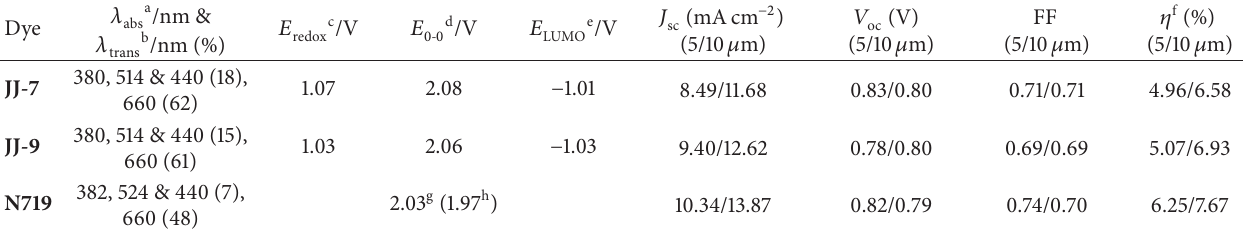
Table 1: Optical, redox, and DSSC performance parameters of